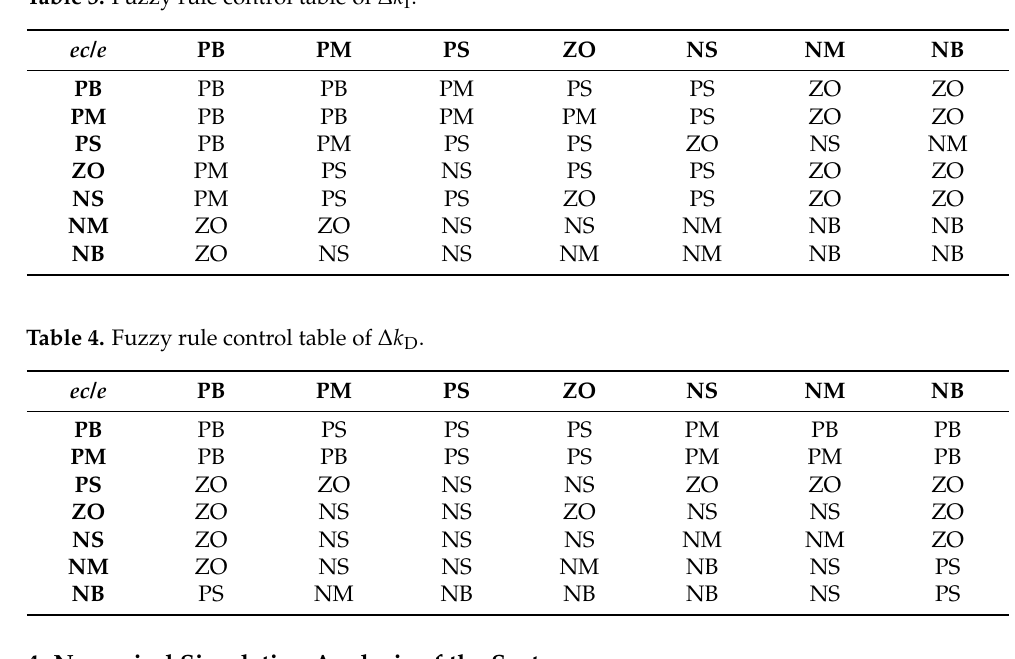
Table 3. Fuzzy rule control table of ∆ k I .